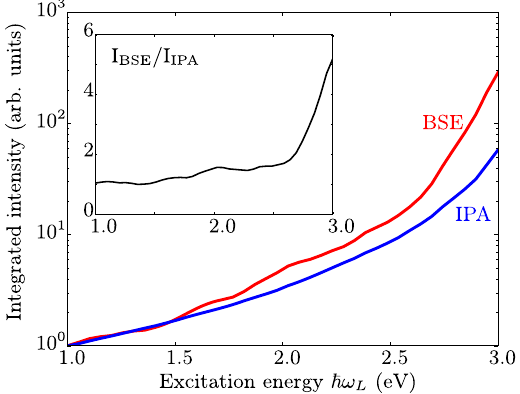
Figure 2. Integrated intensities of BSE and IPA spectra over Raman shifts ranging from 900 cm − 1 to 1050 cm − 1 , as a function of the excitation energy ω spectrum has been renormalized with respect to the value at ω = . 1 0